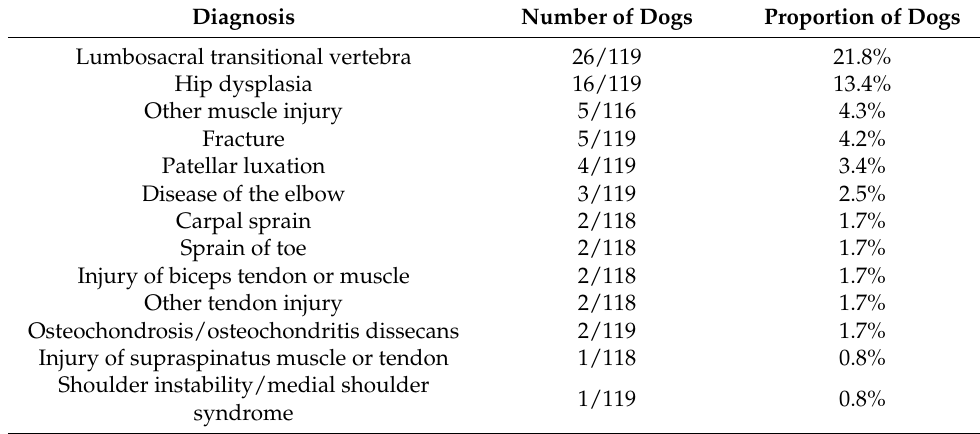
Table 10. Musculoskeletal diagnoses unrelated to the agility-related injury of 2019.